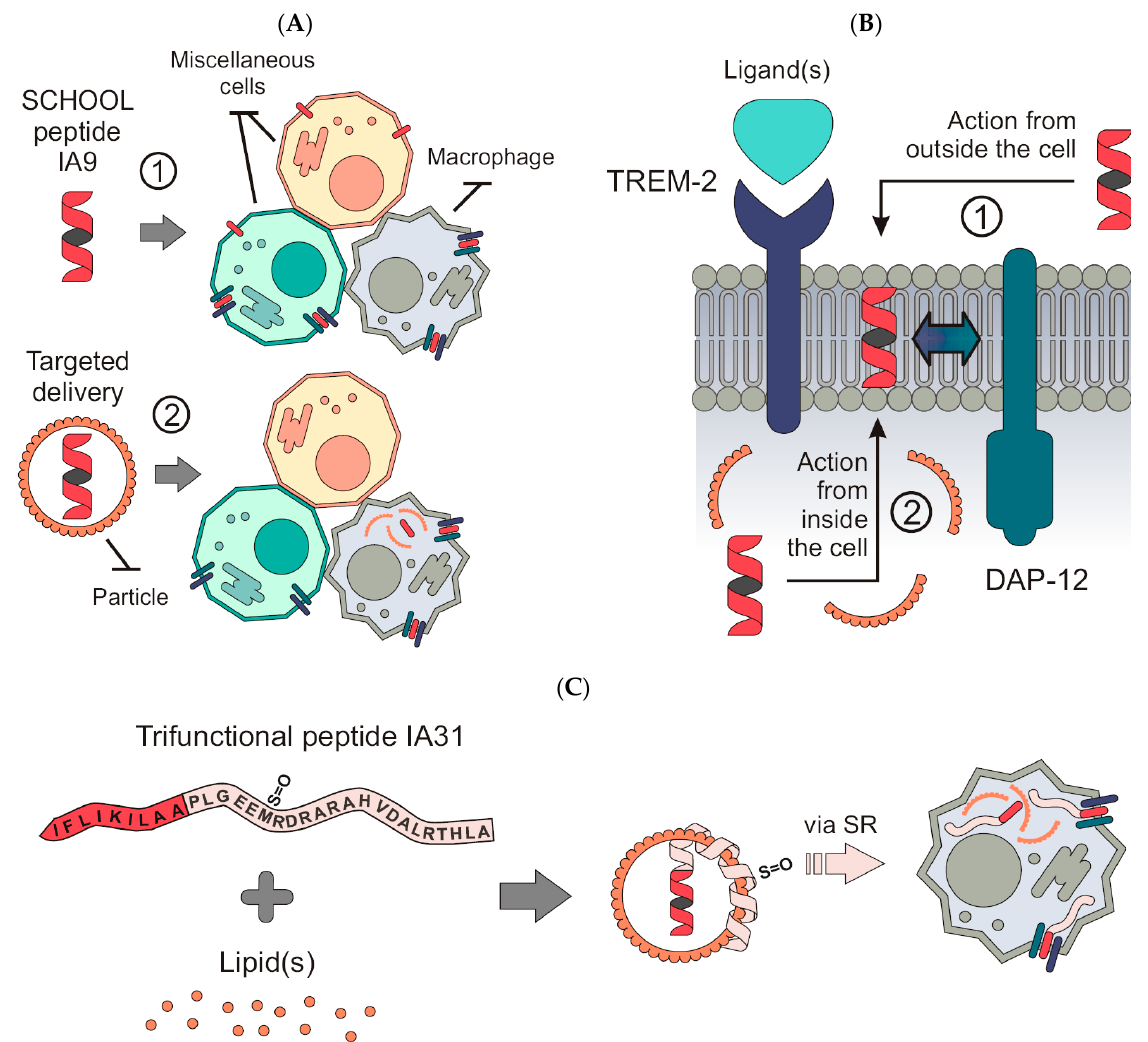
Figure 1. Schematic depiction for the proposed concepts of ligand-independent TREM-2 inhibition and macrophage-targeted drug delivery. ( A ) Peptide IA9 self-inserts into the cell membrane from outside and inhibits TREM-2 on any TREM-2-expressing cell (1). IA9 delivered into macrophages self-inserts into the cell membrane from inside and inhibits TREM-2 expressed on these cells (2). ( B ) Similar to SCHOOL peptide inhibitors of other cell receptors [48], IA9 employs ligand-independent mechanisms of action and blocks interactions between TREM-2 and its signaling partner DAP-12 in the cell membrane. ( C ) Schematic representation of a trifunctional peptide IA31 capable of formation of lipopeptide complexes (IA31-LPC) upon interaction with lipids. Due to sulfoxidized methionine in the PA22 domain, IA31-LPC deliver IA31 to cells (e.g., macrophages) via interaction with scavenger receptor (e.g., type A scavenger receptor, SR-A), where the released IA31 inhibits TREM-2. We demonstrated, for the first time, that in the CIA mouse model, IA9 and IA31-LPC systemically administered after induction of arthritis both markedly suppress the rate of disease progression and joint inflammation, diminish release of plasma and joint proinflammatory cytokines and CSF-1, and significantly decrease synovial tissue sublining CD68, F4/80, TREM-1 and TREM-2 expression. We also comparatively studied TREM-1 inhibitory SCHOOL peptide sequence GF9 in the form of free peptide GF9, and formulated into macrophage-targeted LPC, as part of a trifunctional peptide GA31 (GA31-LPC) [30]. model used in this study compared to that of GF9 and GA31-LPC. Collectively, our